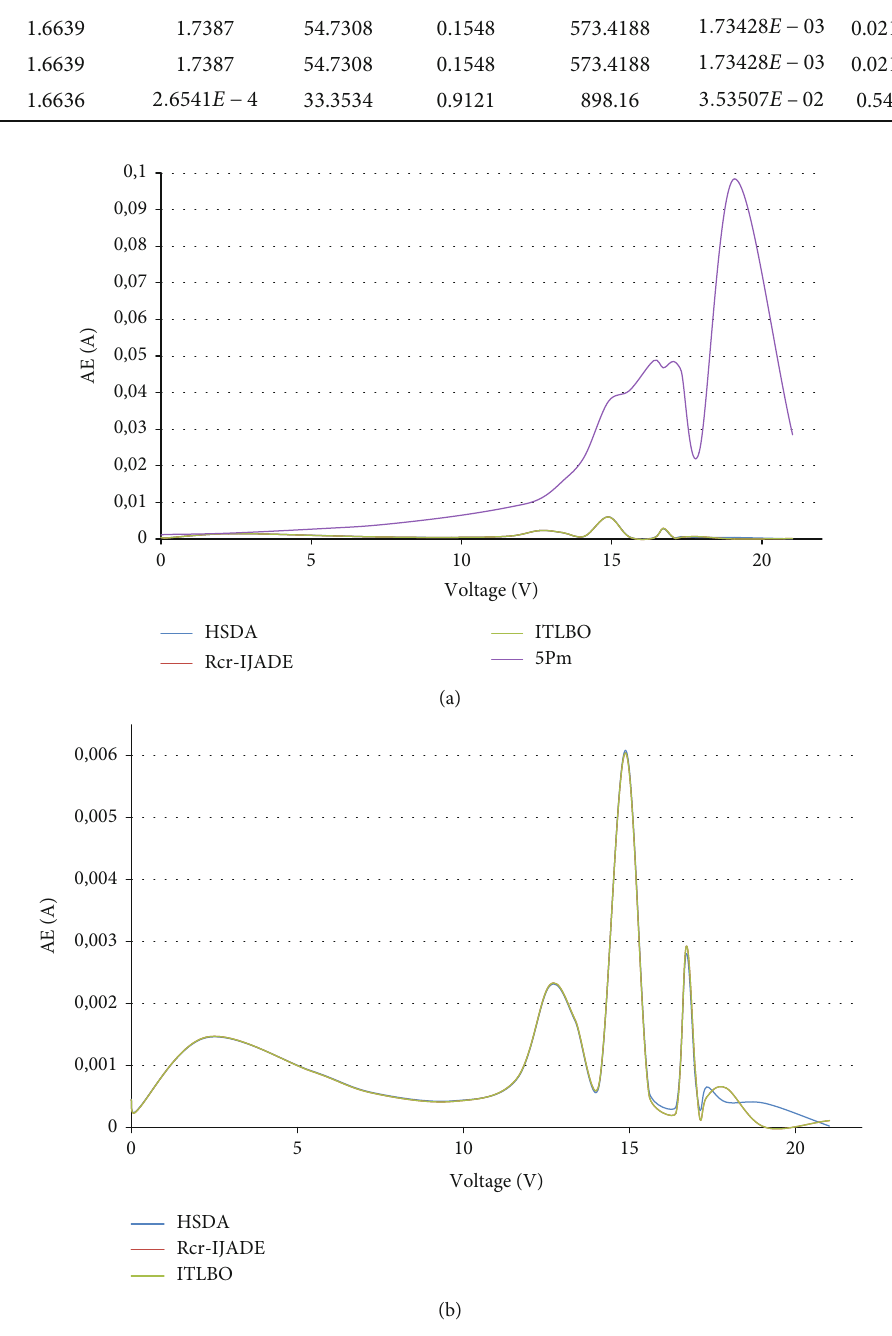
Figure 6: (a) The absolute current error (AE) for STM6-40 photovoltaic panel; (b) AE in open-circuit voltage